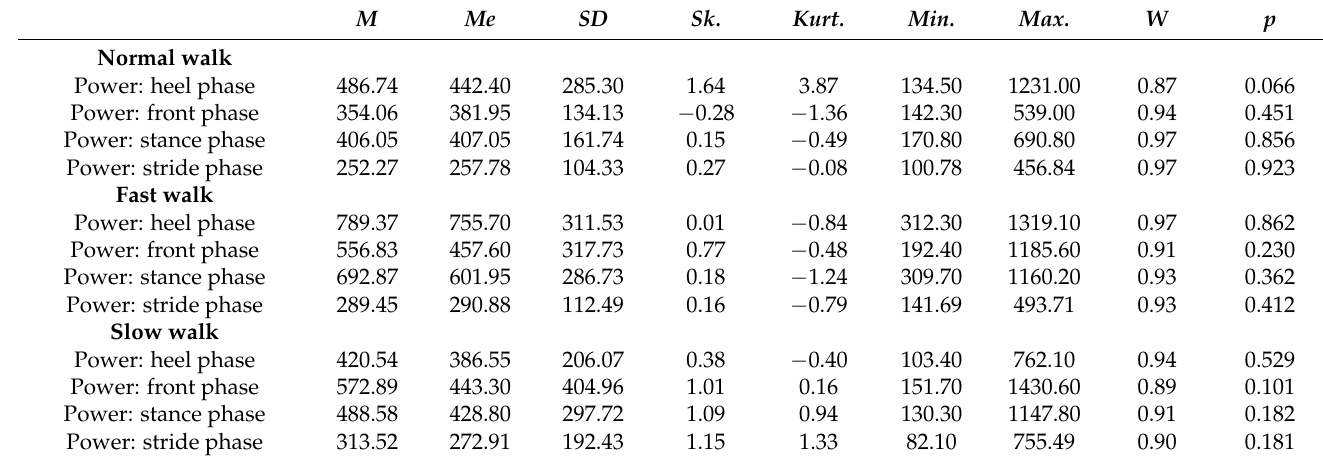
Table A1. Basic descriptive statistics with the results of Shapiro–Wilk test.